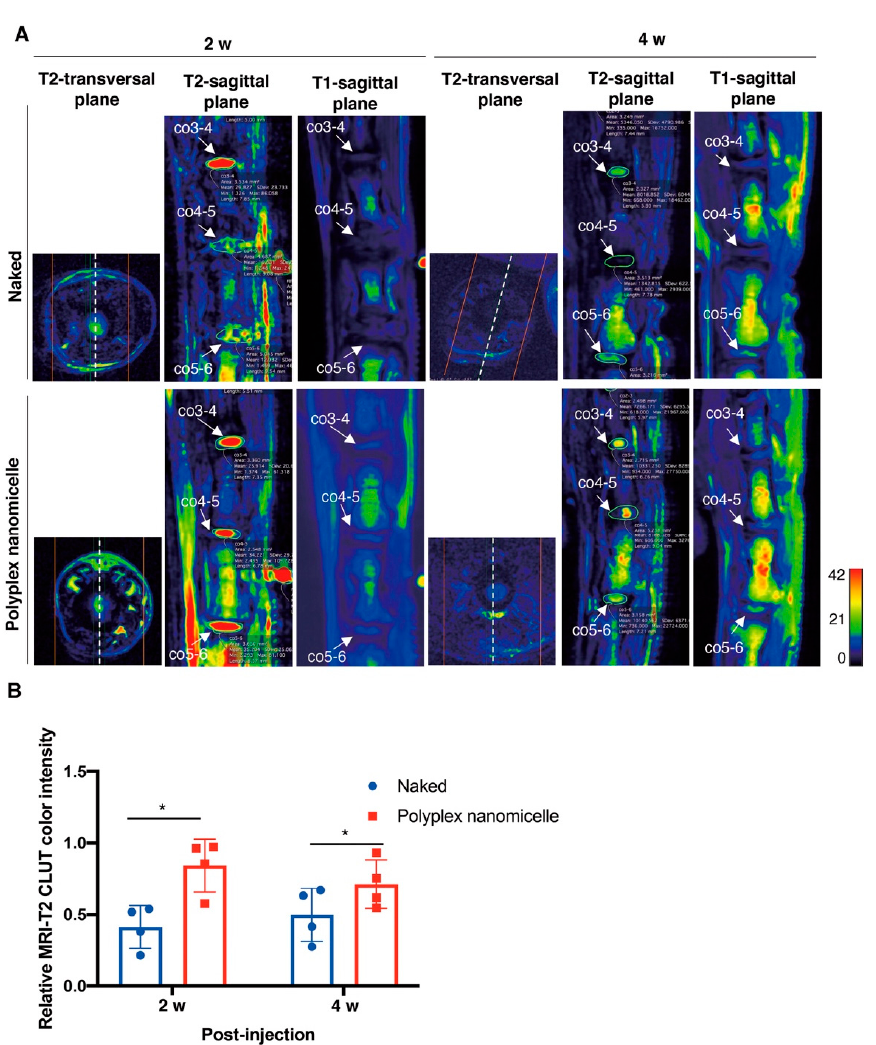
Figure 4. Runx1 mRNA delivery in the coccygeal disc defect, and MRI examinations for detecting the change in hydration of punctured discs in rats. ( A ) Runx1 mRNA was injected in naked form compared with that loaded in polyplex nanomicelle form, and MRI was carried out at 2- and 4-weeks post-injection. Representative images show the T1- and T2-weighted MRIs, which were converted to color histograms based on the CLUT in OsiriX MD software. Due to the disc defect being created in the co4-5, the T2-transversal plane shows the T2-weighted image retrieved from the co_4-5 in the sagittal plane to directly present the damaged disc’s hydration content. The region of interest (ROI) was circled at co_3-4, co_4-5, and co_5-6 in the T2-weighted image from the sagittal plane for subsequent CLUT color intensity calculation. ( B ) Relative MRI-T2 CLUT color intensity was calculated from the ROIs of co_3-4, co_4-5, and co_5-6 in the T2-weighted image from the sagittal plane according to the Equation shown in the Materials and Methods. n = 5; * p <